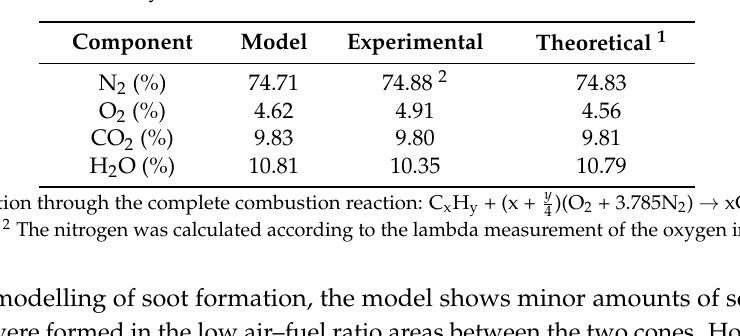
Table 2. Outlet gas composition for the main components for model, experimental results (6 kW burner, lambda 1.3), and theoretically calculated results.